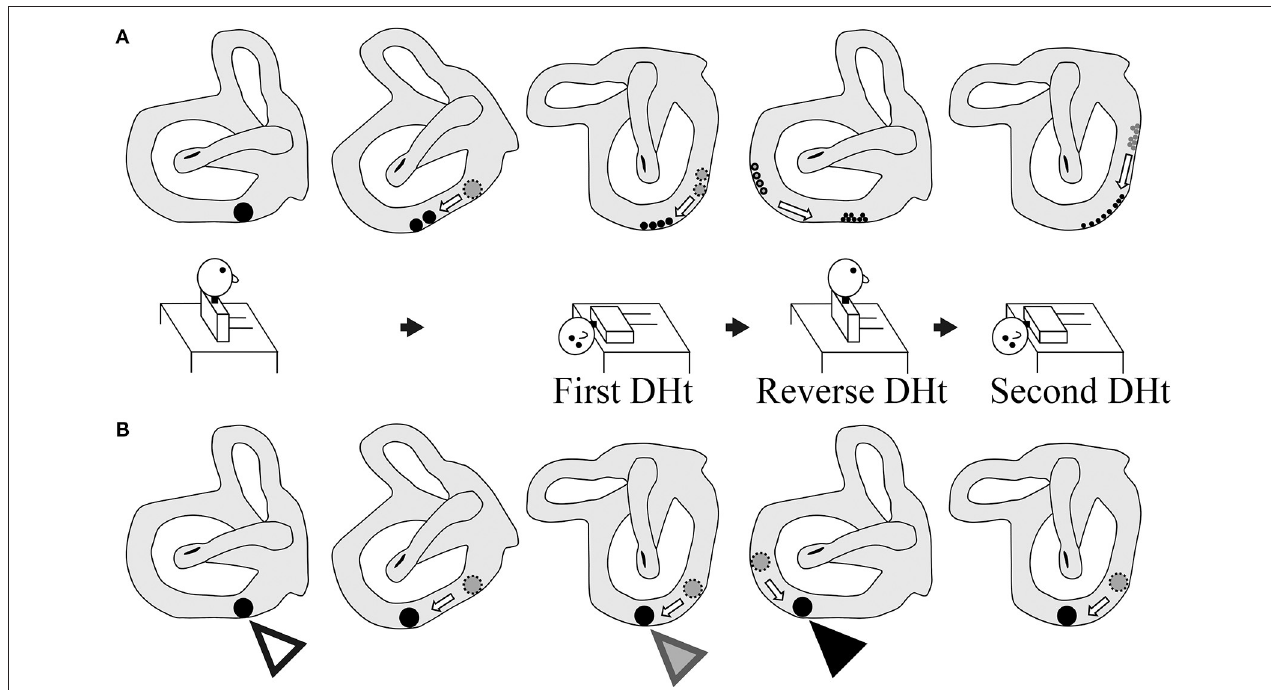
FIGURE 5 | Two theories of the pathophysiology of BPPV fatigue. (A) Popular theory. As the size of the otoconial debris before the second Dix–Hallpike test is smaller than that before the first Dix–Hallpike test, the positional nystagmus is weaker following the second Dix–Hallpike test. Thus, the pathophysiology of BPPV fatigue involves dispersal of the otoconial debris in a semicircular canal during the head movement in the Dix–Hallpike test. (B) Boselli theory. The initial position of the otoconial debris before the first Dix–Hallpike test is shown by a white triangle. The position of the otoconial debris after the head movement of the first Dix–Hallpike test is shown by a gray triangle. From this head position, the patient’s head is moved to the sitting position by the reverse Dix–Hallpike test, and the position of the otoconial debris when in the sitting position (i.e., just before performing the second Dix–Hallpike test) is shown by a black triangle. The second trajectory of the otoconial debris following the second Dix–Hallpike test is shown in the right figure. The trajectory of the otoconial debris is shorter than that for the first trajectory at the first Dix–Hallpike test (the first trajectory is between the white and gray triangles). The movement of the otoconial debris along the second short trajectory causes smaller cupula displacements than that for the first movement along the first long trajectory. Thus, the intensity of the positional nystagmus induced by the second Dix–Hallpike test is smaller than that following the first Dix–Hallpike test. As such, the pathophysiology of BPPV fatigue involves the otoconial debris not returning to its initial position after the first Dix–Hallpike